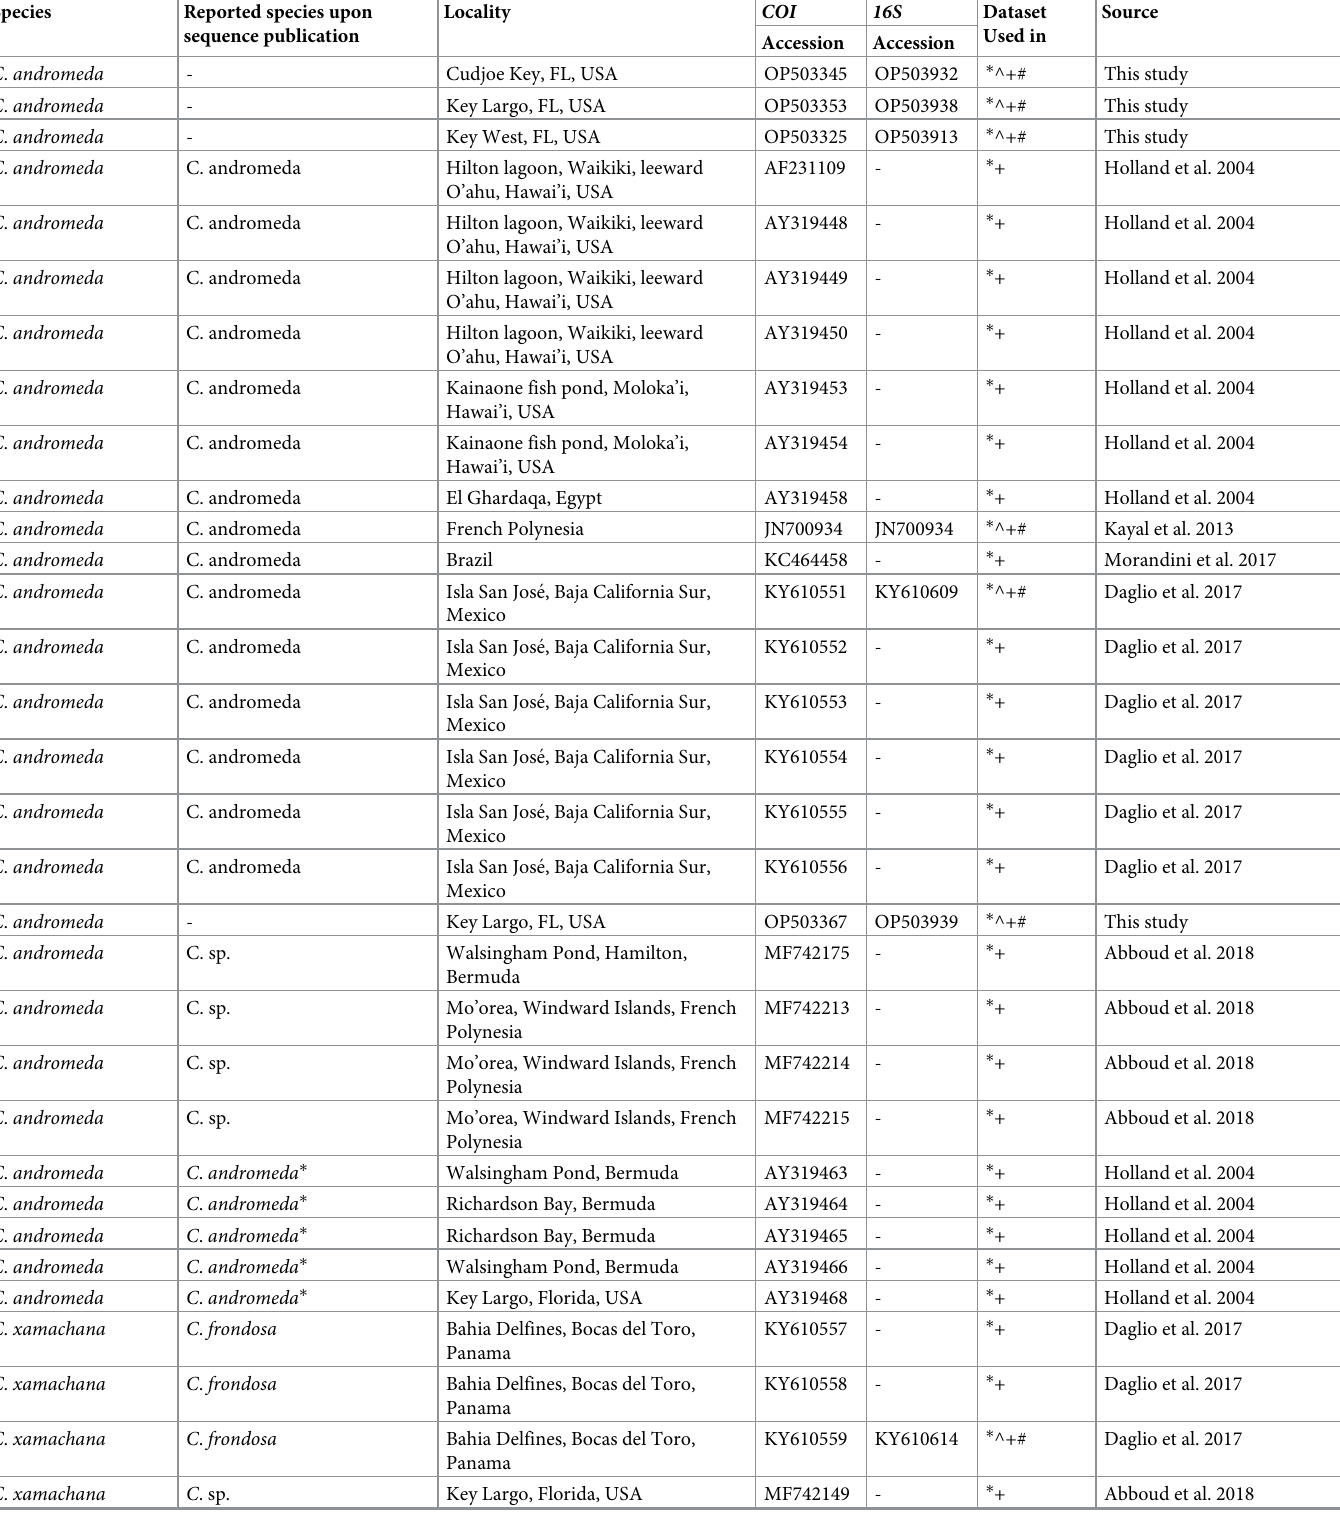
Table 1. COI and 16S sequences used for combined tree generation, with both original identity from source and identity post-analysis.